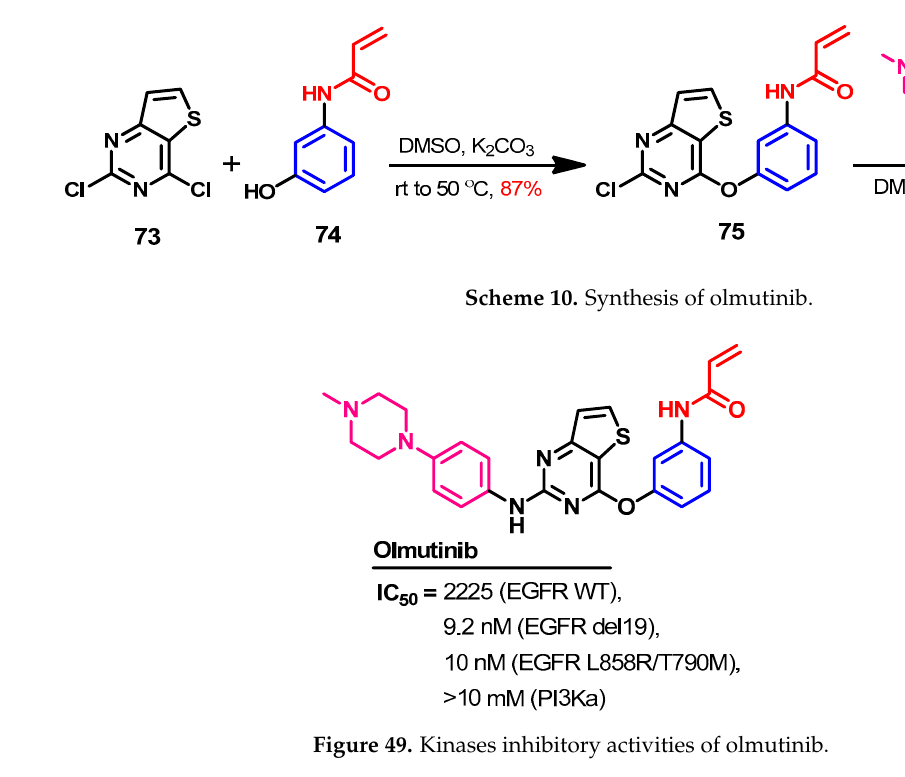
Figure 49. Kinases inhibitory activities of olmutinib.